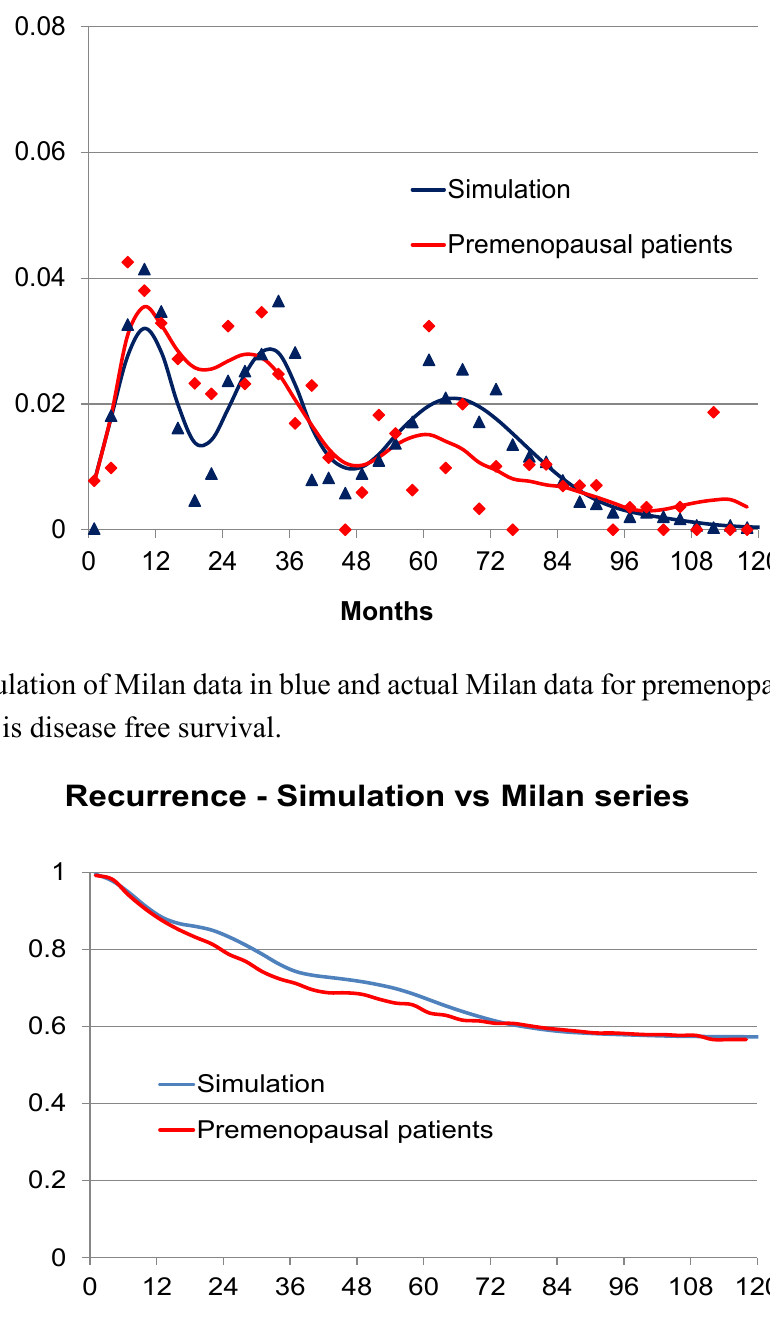
Figure 5. Simulation of Milan data in blue and actual Milan data for premenopausal patients in red. Format is hazard of relapse. We are comparing the Milan data for premenopausal patients and the simulation. We adjusted the simulation to try and agree with hazard for the Milan data. Time scale is 120 months.